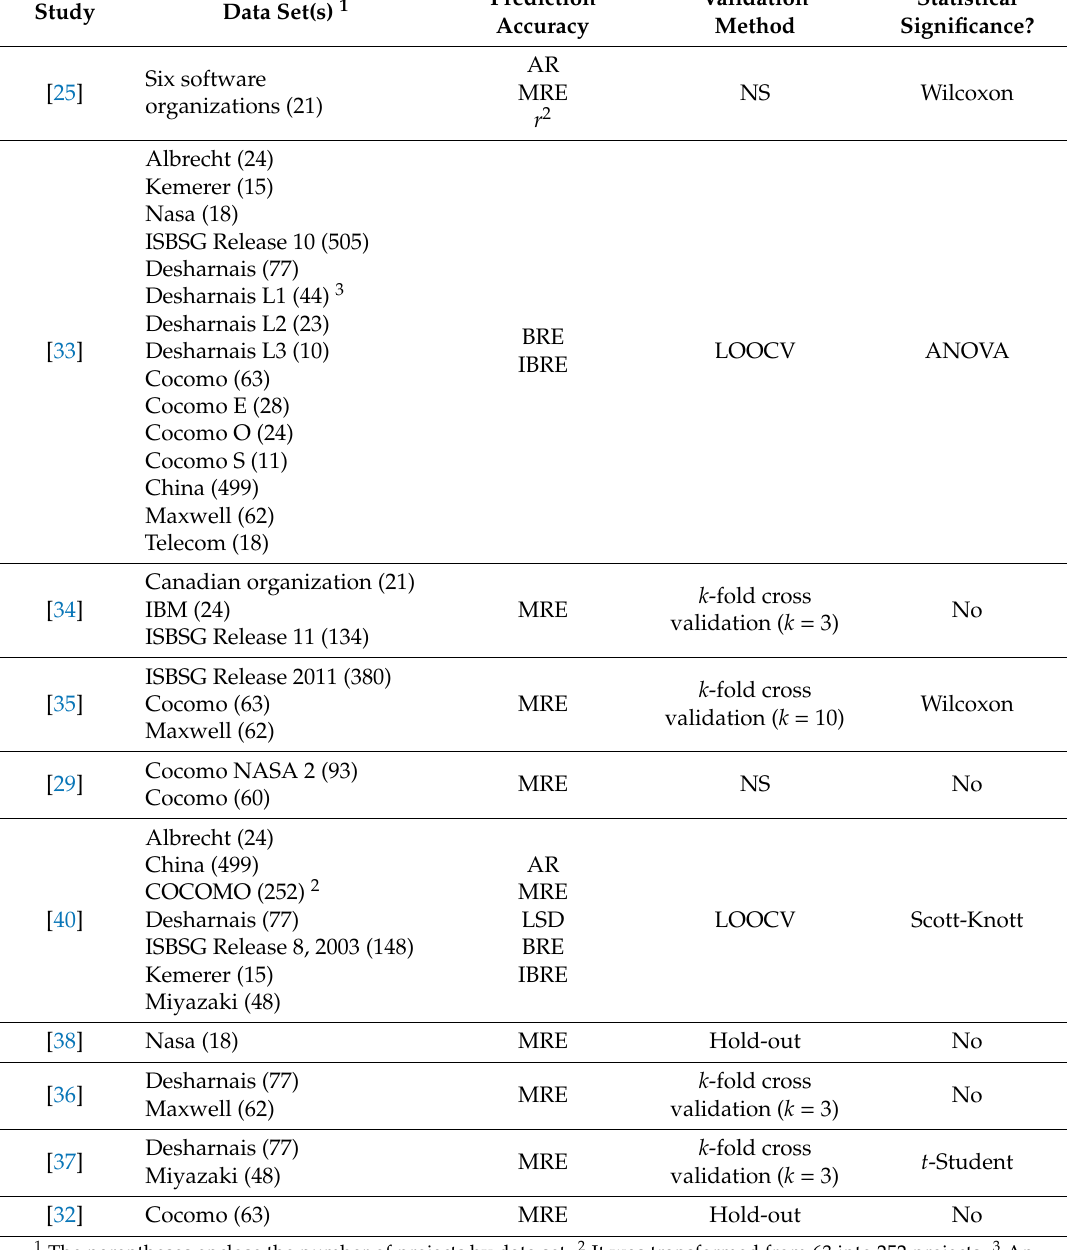
Study Data Set(s)